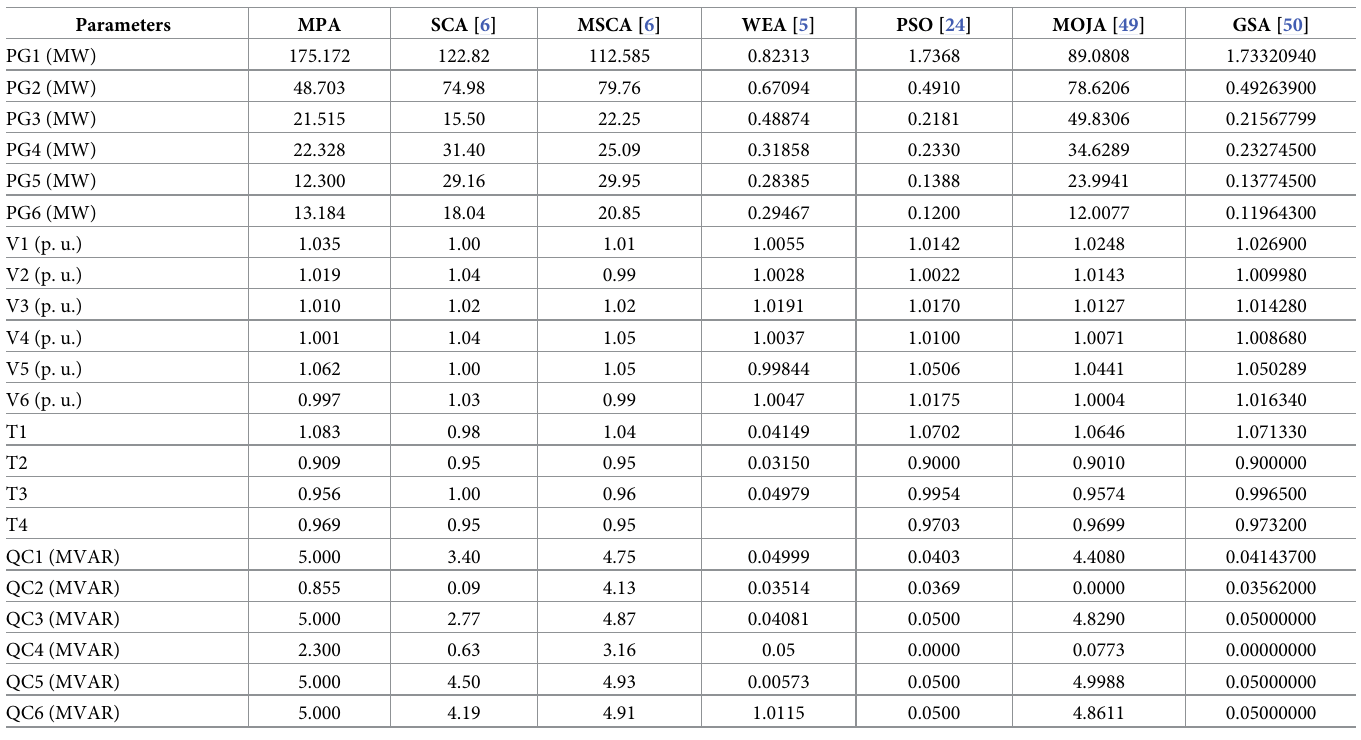
Table 5. Comparison of proposed algorithm with other literature work for case